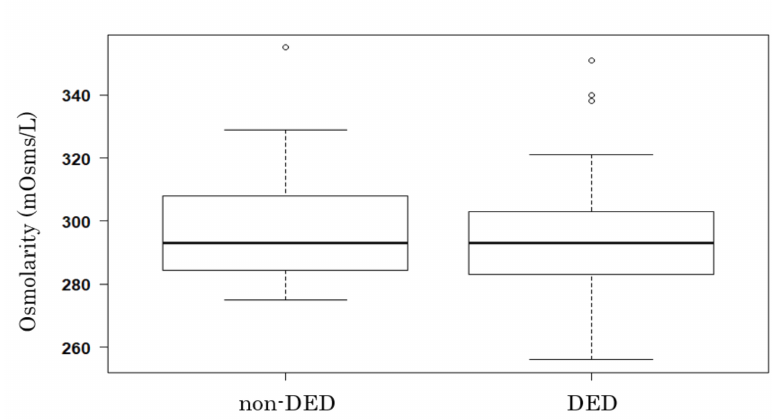
Figure 1. The mean osmolarity values of non-dry eye disease (non-DED; n = 51) and DED ( n = 71) eyes were 297.76 ± 16.72 and 294.76 ± 16.39 mOsms / L, respectively ( t -test, p = 0.32). Bold line denotes median, and upper and lower ends of the box denote 75th and 25th percentile, respectively. Upper and lower error bars denote maximum and minimum values, respectively.